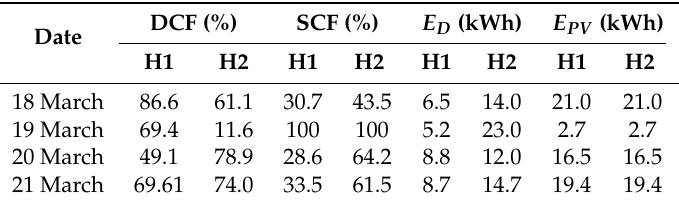
Table 1. Indicator and energy figures for individual simulations. Comparison of 2 households. H,